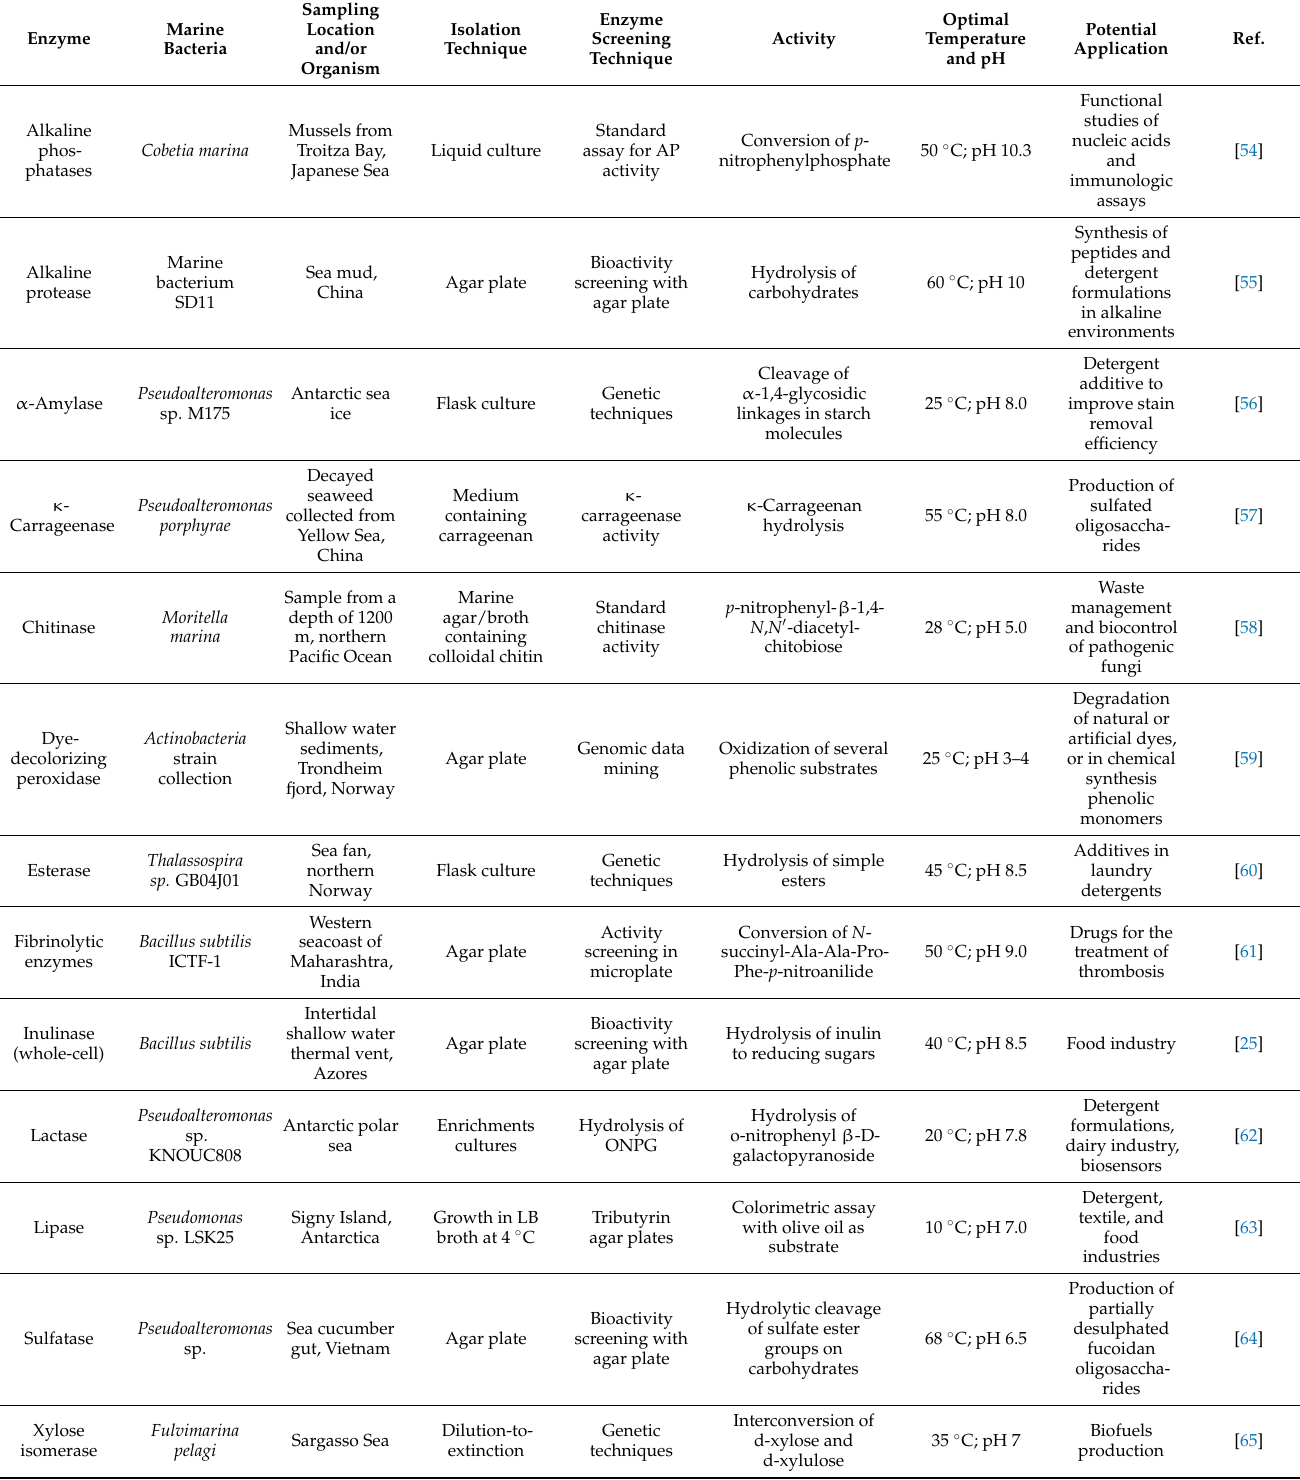
Table 1. Examples of enzymes from marine bacteria reported in the last two decades and their potential